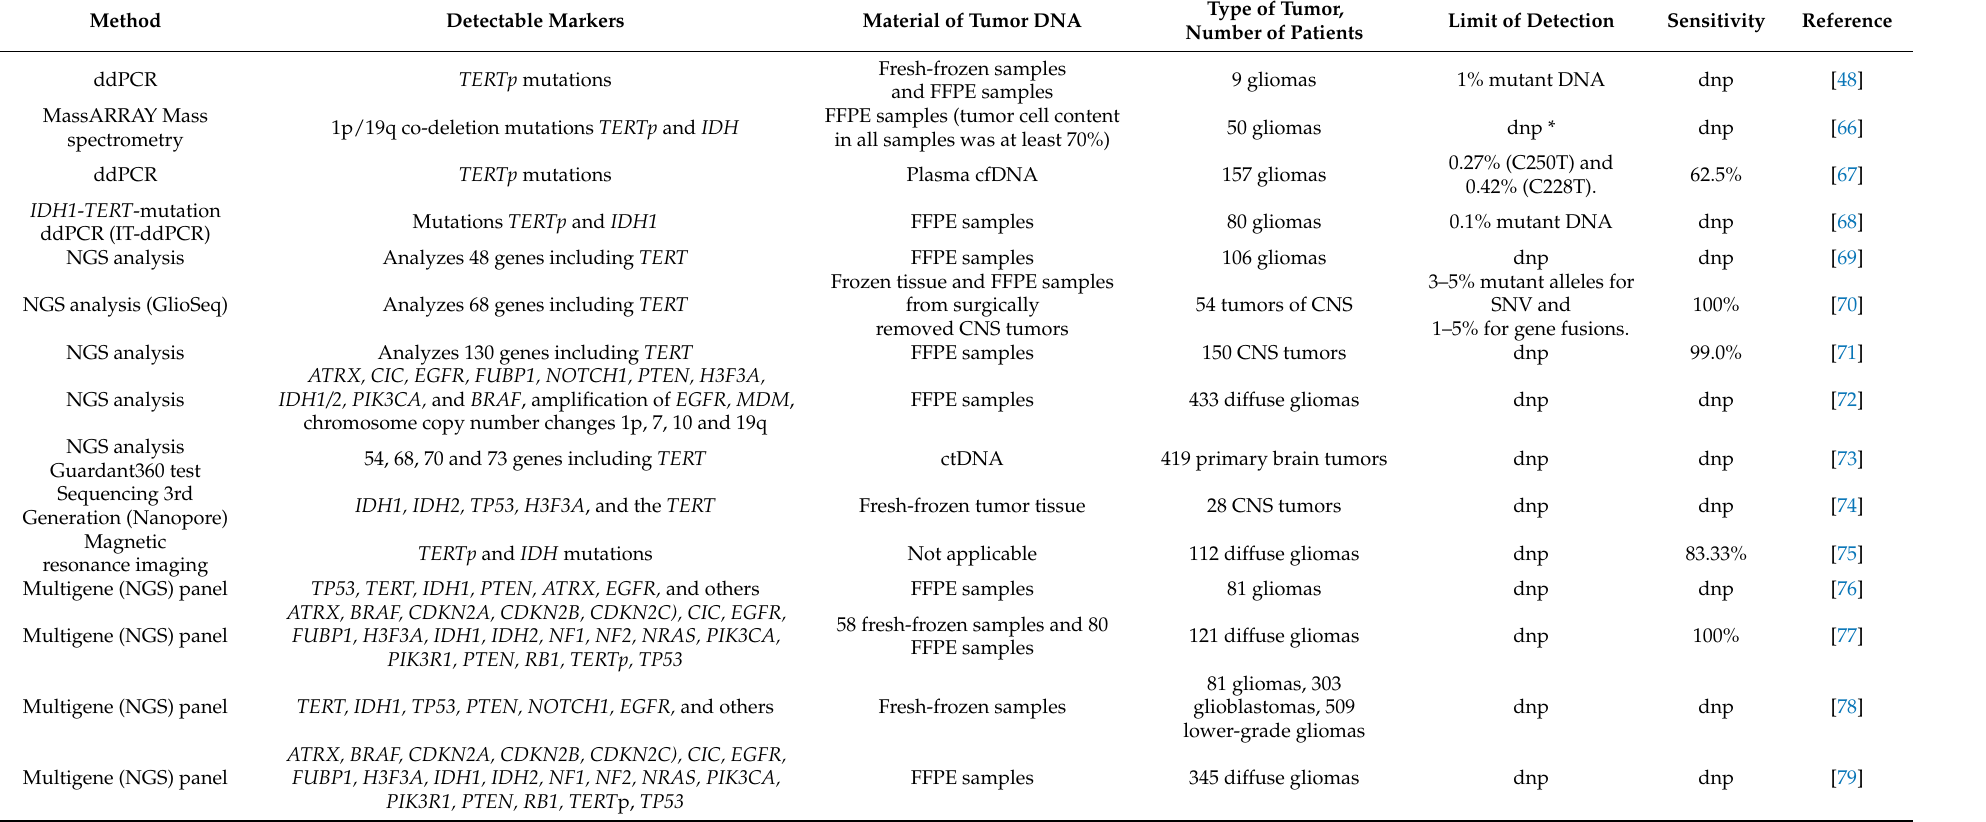
Table 3. Diagnostic characteristics of different methods for detecting TERTp